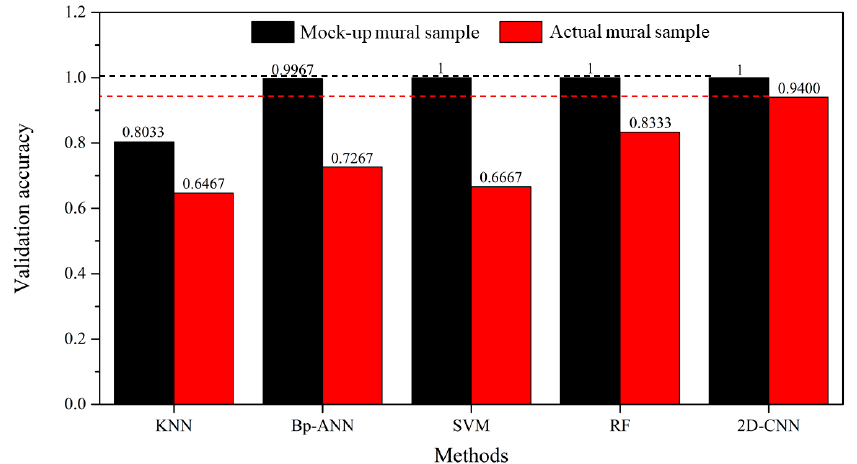
Figure 13. The accuracy comparison results of all methods for mock-up mural samples and actual mural fragments.